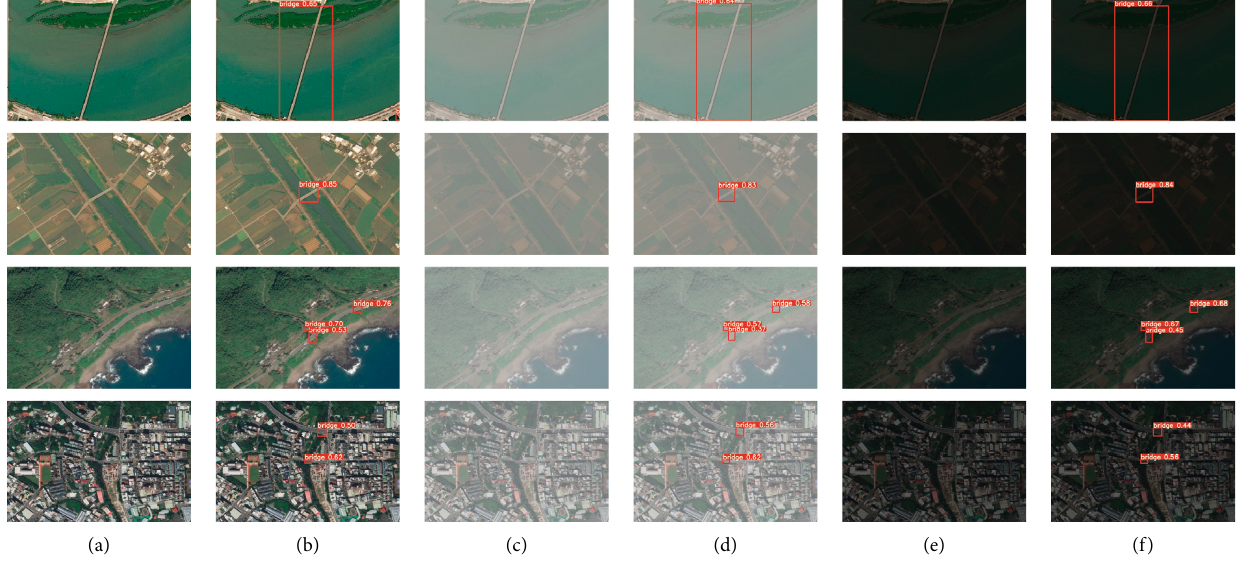
Figure 14: The comparisons of YOLOv5s network under normal, hazy, and low-light imaging conditions. (a) Original. (b) Origi- nal+YOLOv5s. (c) Hazy. (d) Hay+ YOLOv5s. (e) Low-light. (f) Low-light